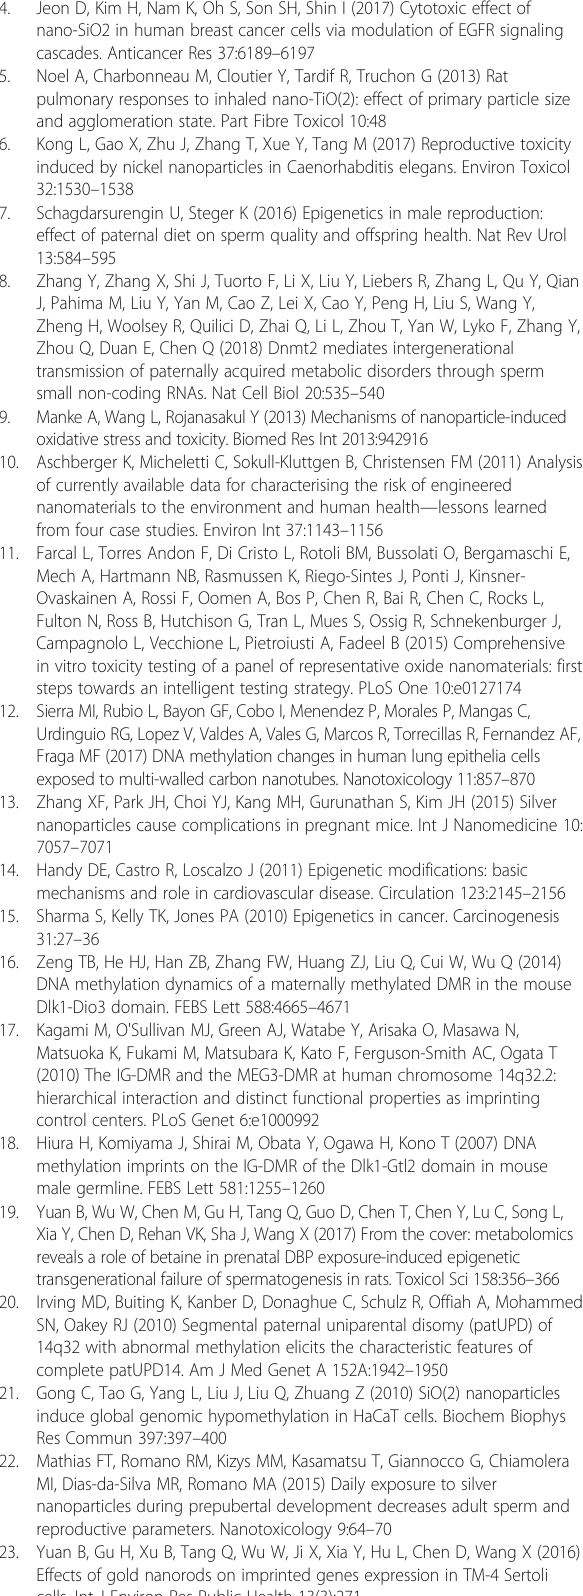
Additional file 1: Table S1. List of 24 homologous imprinted genes. Table S2. List of primers used to test the expression of the 24 imprinted genes and the reference genes Gapdh and U6. (ZIP 22